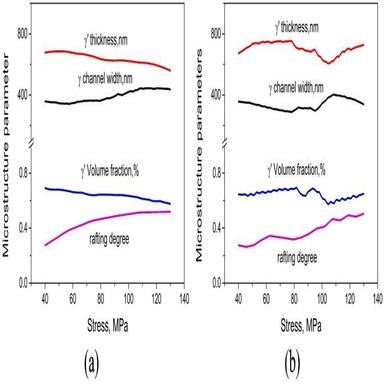
Quantitative parameters of γ/γ' two-phase microstructure of arc-section specimen after creep at 1100 ◦C for 100 h. (a) dendrite region only, (b) dendrite region + interdendtritic region.